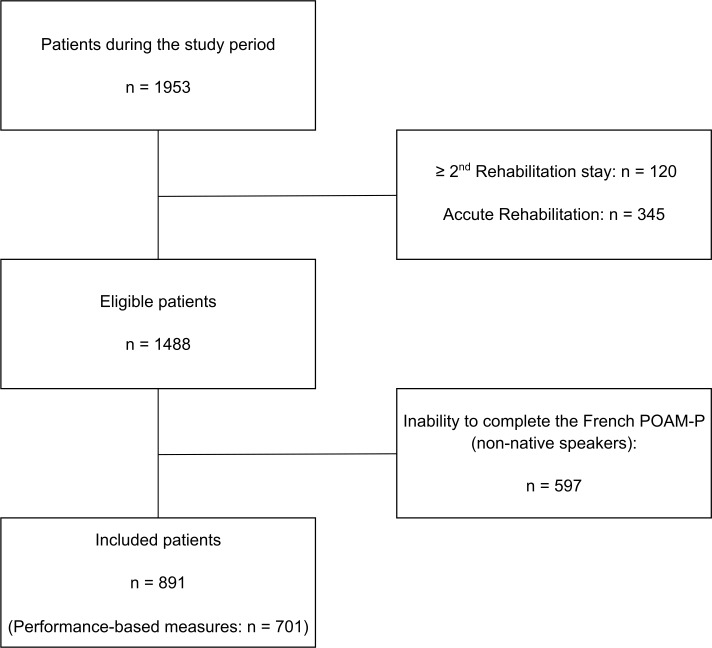
Flow chart of the study.